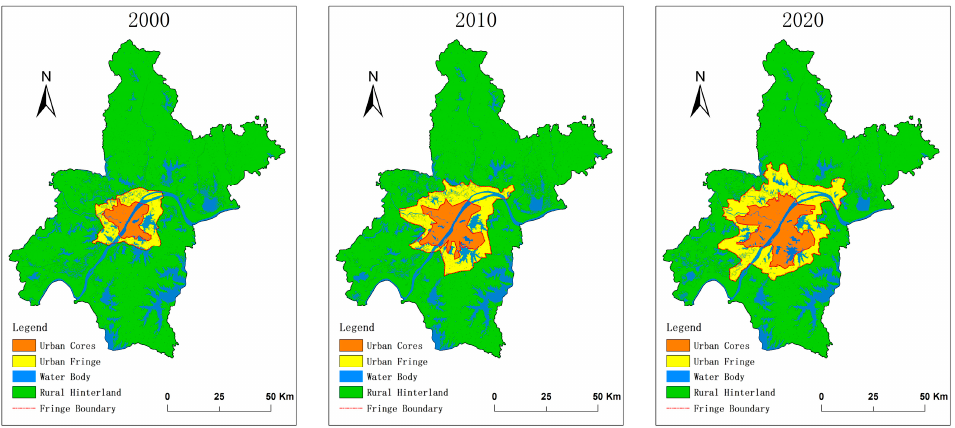
Figure 7. Spatial distribution of urban fringe areas in Wuhan from 2000 to 2020.